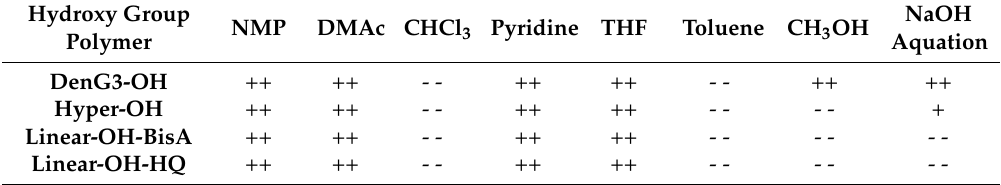
Table 2. Solubilities of DenG3-OH , Hyper-OH , Linear-OH-BisA , and Linear-OH-HQ .